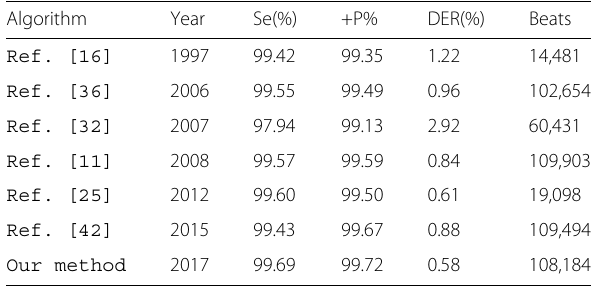
Table 5 Comparison of R-peak detection with other algorithms